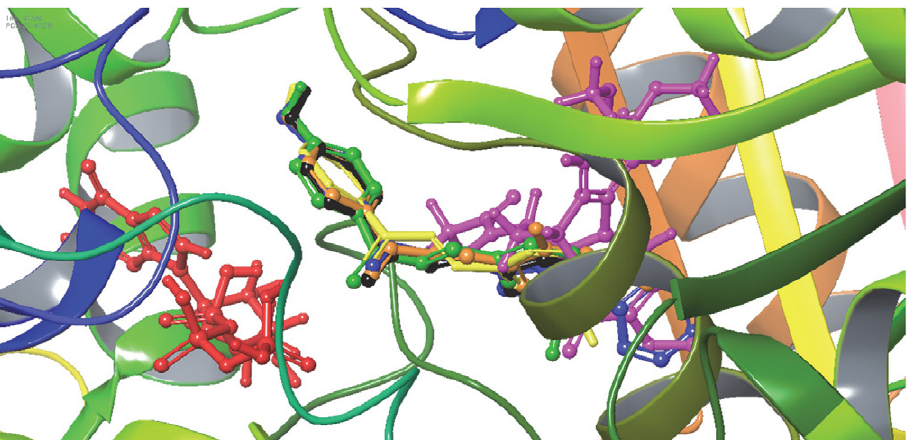
Figure 3. Compounds 7 (blue), 8 (yellow), 9 (orange), 10 (green), and 11 (black), colchicine (pink) and guanosine-5’-triphosphate (red) are present- ed in the tubulin-colchicine complex binding